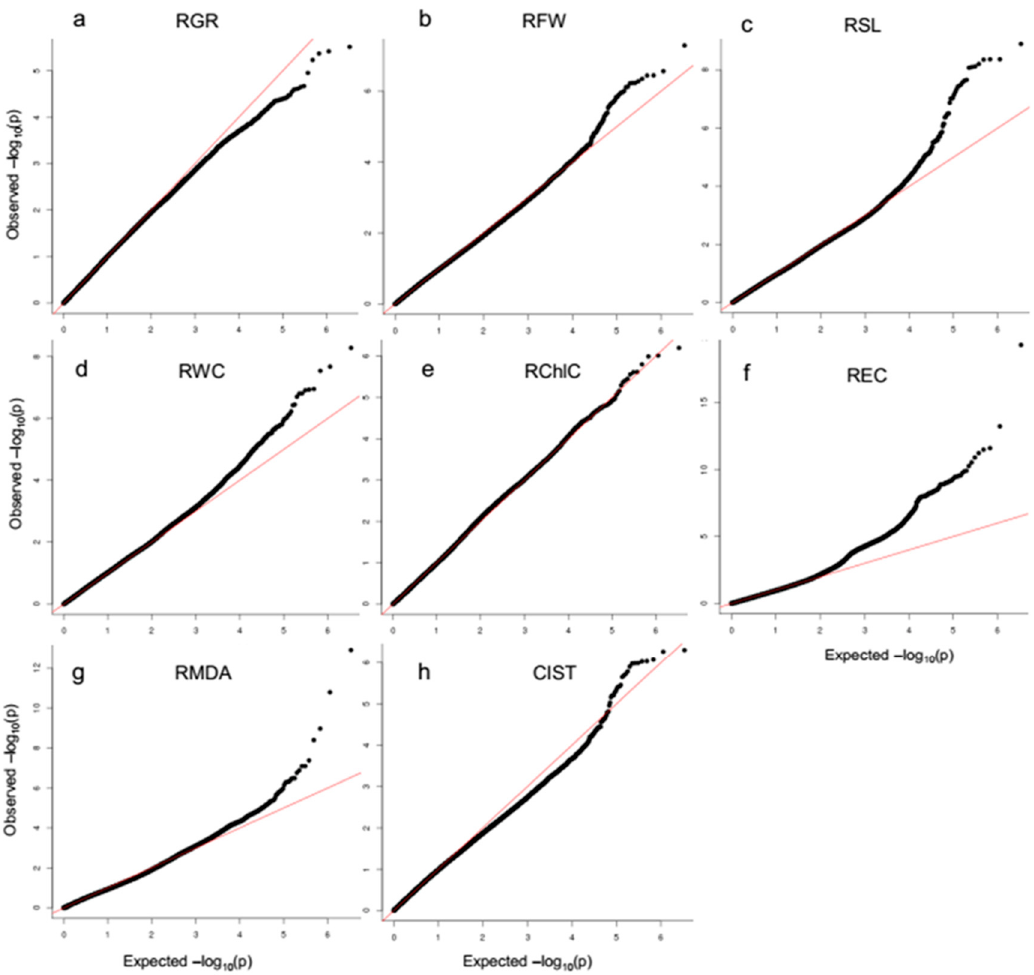
Figure 2. Quantile-quantile plots of versus expected − log 10 P values of GWAS result. The red dashed line in each plot represents an idealized case where theoretical test statistics quantile match simulated test statistic quantile. ( a ) Relative germination rate (RGR). ( b ) Relative fresh weight (RFW). ( c ) Relative stem length (RSL). ( d ) Relative water content (RWC). ( e ) Relative chlorophyll content (RChlC). ( f ) Relative electric conductivity (REC). ( g ) Relative MDA (RMDA). ( h ) Comprehensive index of salt tolerance (CIST).